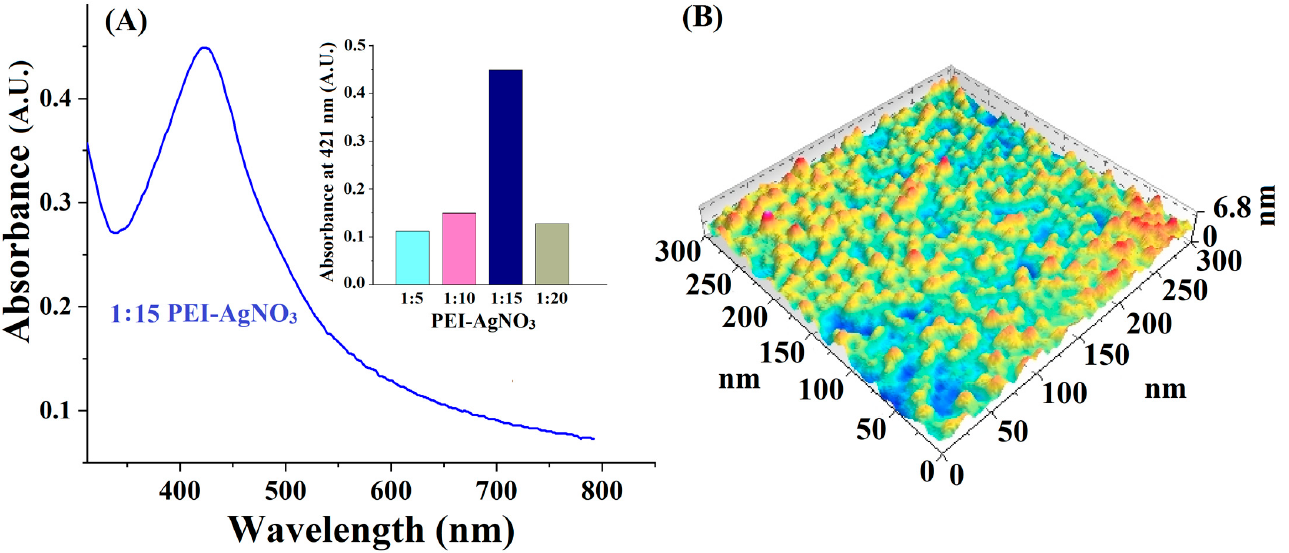
Figure 1. ( A ) UV-visible spectrum of the PEI-AgNPs; inset shows absorbance while using different ratios of PEI and AgNO 3 ; ( B ) 3D AFM image of PEI-AgNPs [PEI:AgNO 3 = 1:15 ( v / v